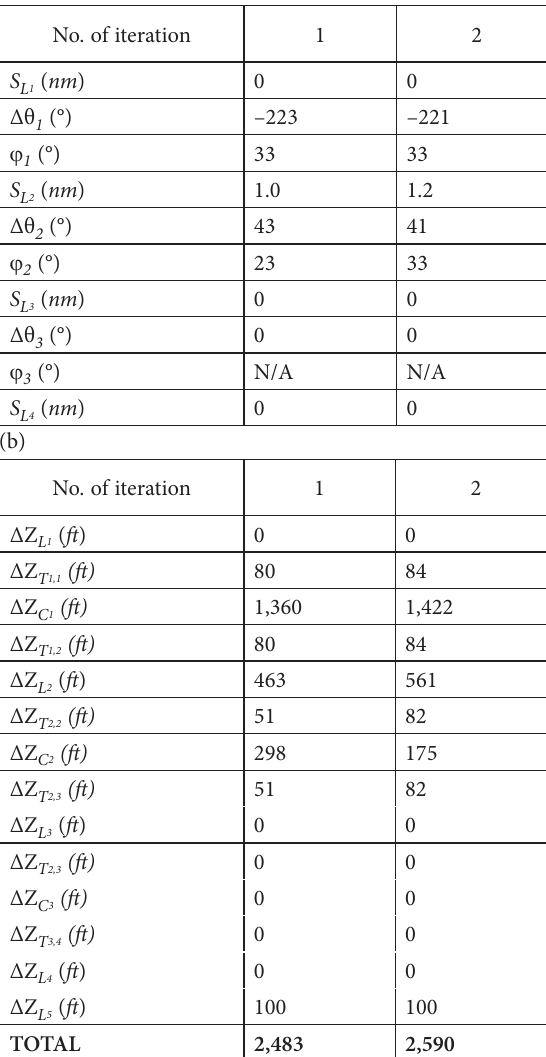
Table 1. Numerical solutions to the optimization problem for v = 160KCAS: (a) adjustables; (b) altitude loss; (c) convergence criterion